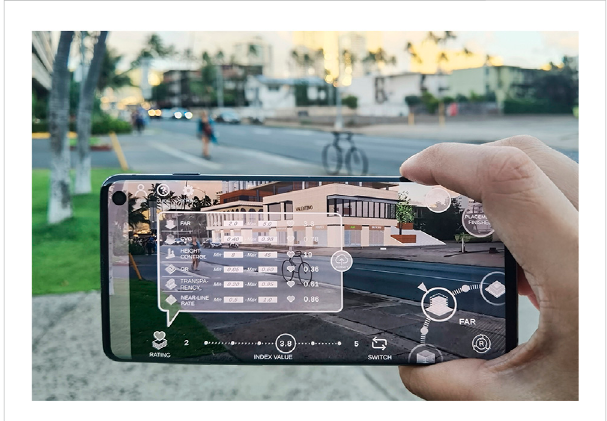
FIGURE 2 Interface of the rating panel. Created with Unity Personal version and AR Foundation